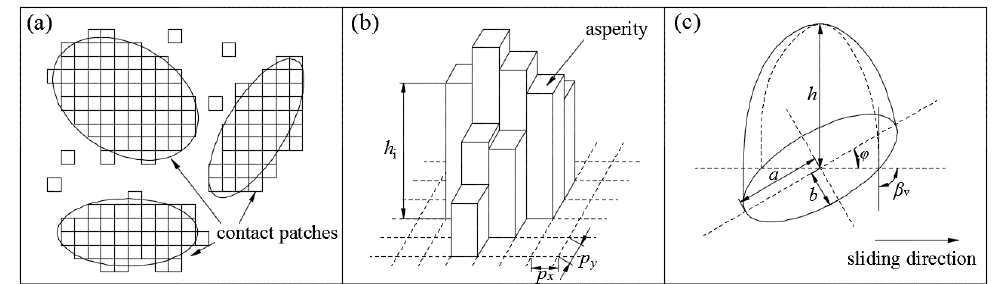
Figure 9. Structure of contact patches and an elliptical paraboloid [32]. ( a ) Contact patches in mean plane; ( b ) discrete asperities; ( c ) equivalent elliptical paraboloid.